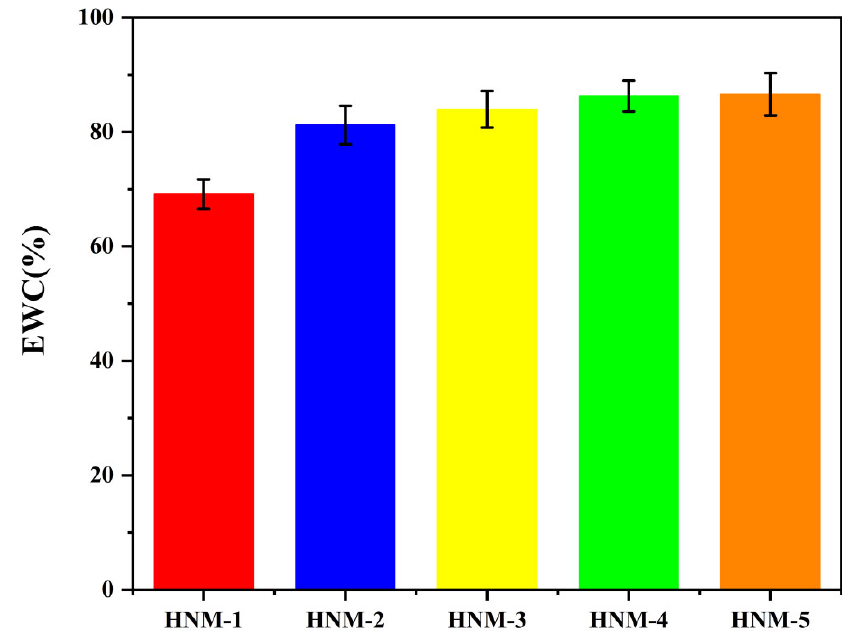
Figure 4. Equilibrium water content of HNM ‐ 1, HNM ‐ 2, HNM ‐ 3, HNM ‐ 4, and HNM ‐ 5.